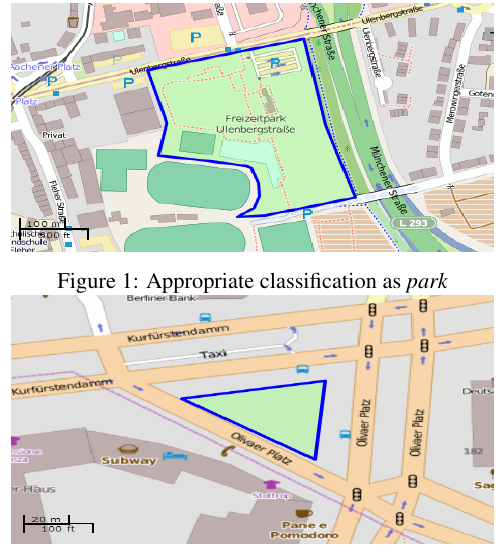
Figure 2: Inappropriate classification as